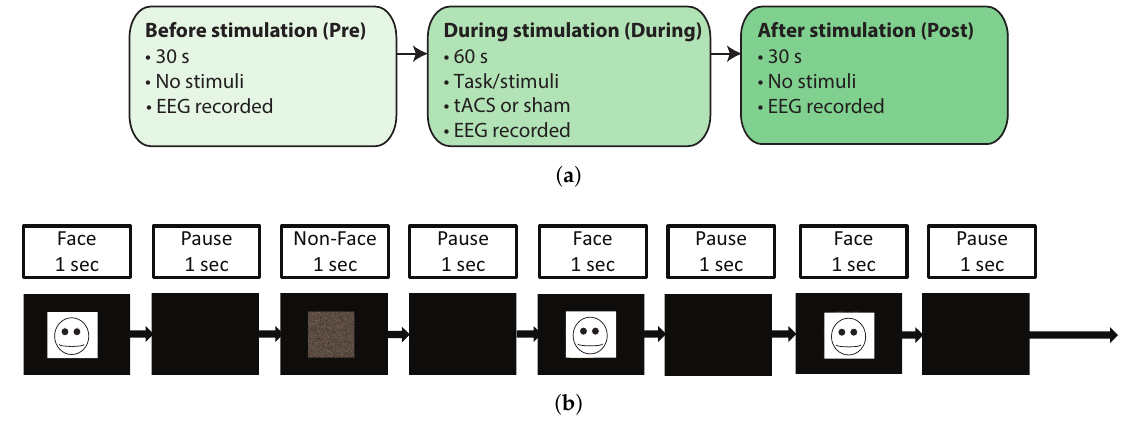
Figure 5. Overview of experimental protocols. ( a ) The Pre and Post stages are 30 s long with no stimuli presented. The During stage is a minute long task/stimuli which is presented during tACS stimulation or during a sham where the same task is performed but no tACS is applied. ( b ) Visual evoked response task protocol. Face and non-face images were shown in a randomized order for 1 s at a time followed by a 1 s pause with a blank screen. This figure shows an example of a randomized face, non-face,